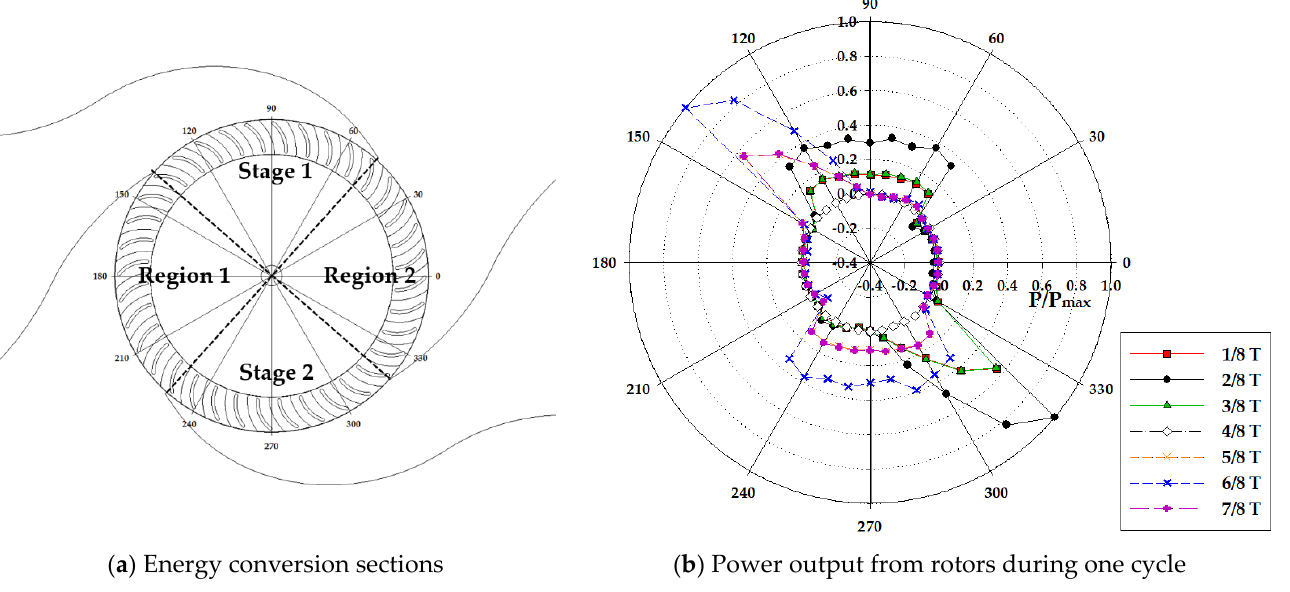
Figure 9. Turbine power generation on the rotor for Φ = 0.67 and ω = 700 rpm .